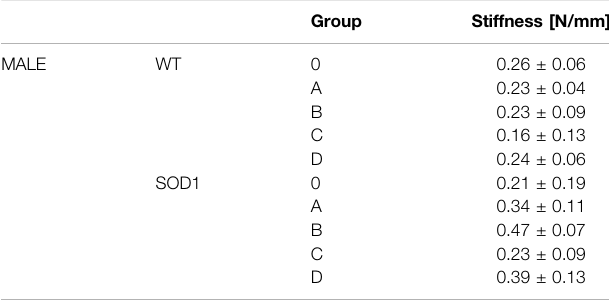
TABLE 1 | Lung stiffness of SOD1 G93A (SOD1) mutated, and wild-type (WT) rats are represented in the table as mean ± SD. Group Stiffness